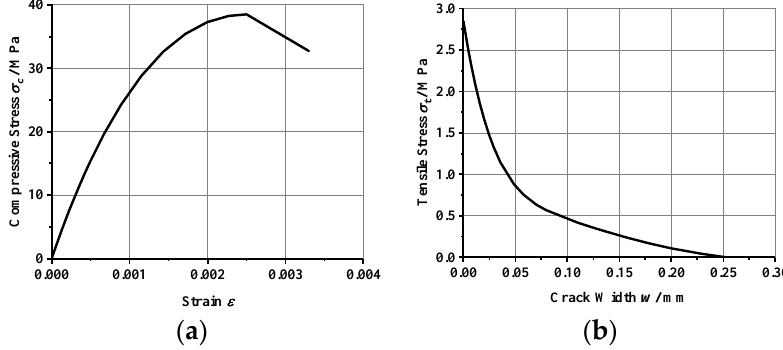
Figure 4. Concrete constitution: ( a ) concrete in compression, ( b ) concrete in tension.